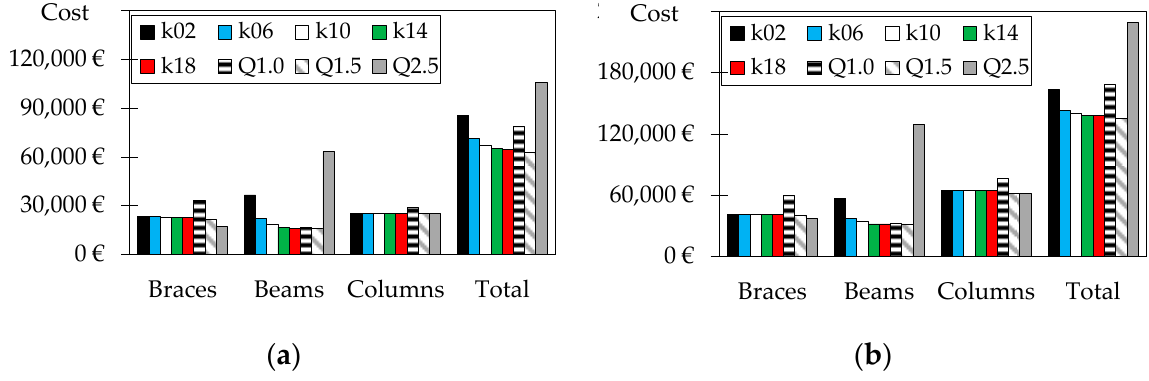
Figure 2. Structural costs of members of the braced frames: ( a ) 4-storey structures; ( b ) 8-storey struc- tures.